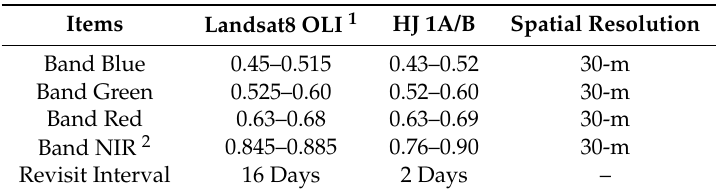
Table 3. Band comparison of Landsat8 with HJ 1 A/B.